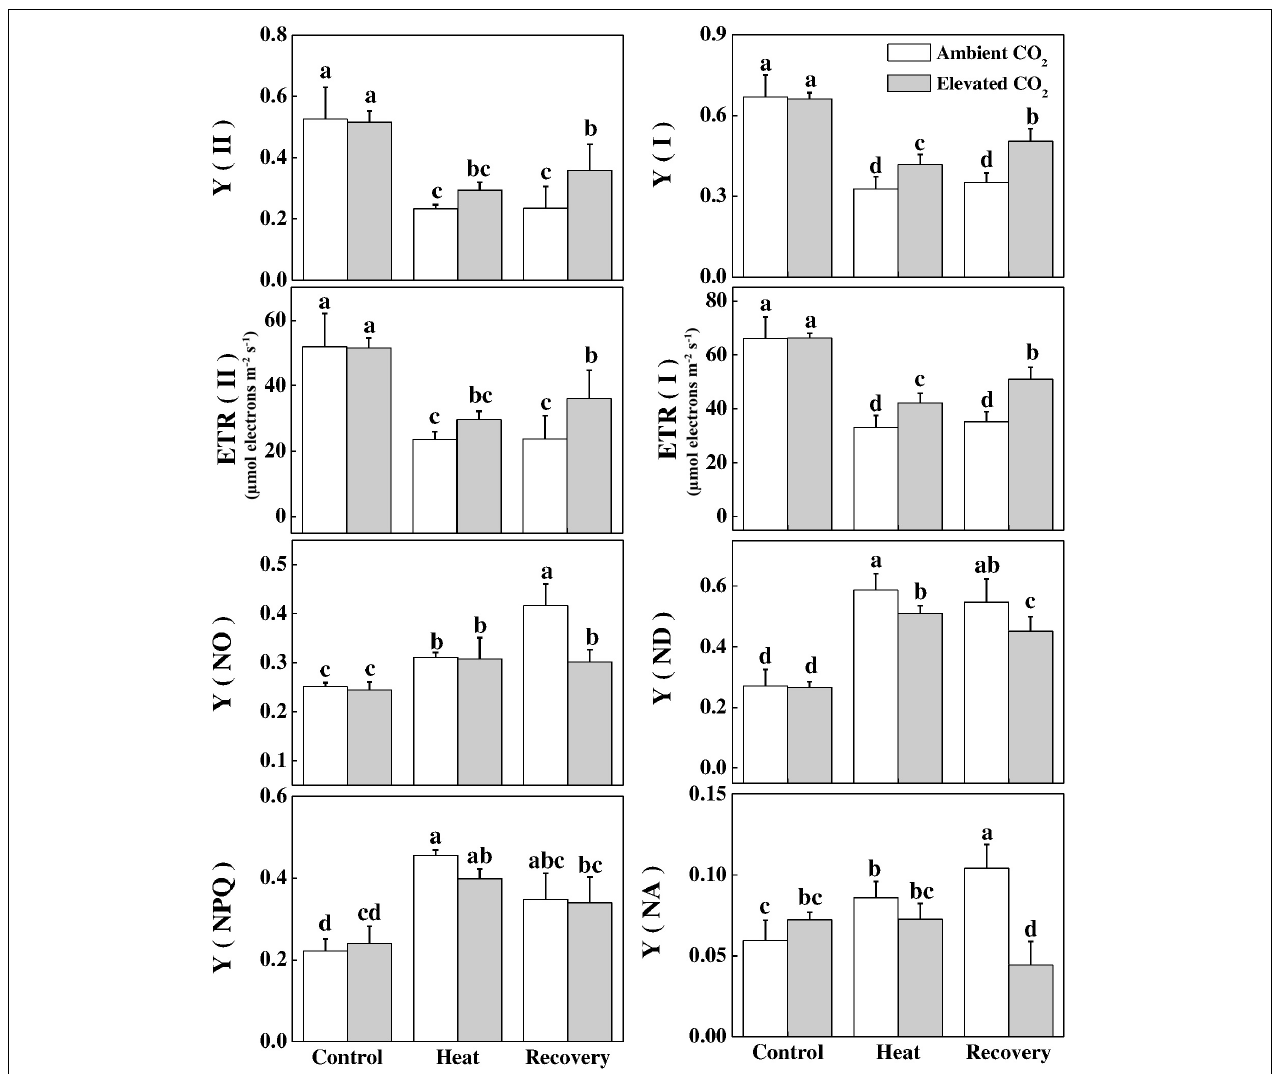
FIGURE 4 | Effects of elevated CO 2 and heat stress either alone or combined on different chlorophyll fluorescence parameters in tomato plants. Tomato seedlings kept at ambient (380 µ mol mol − 1 ) and elevated CO 2 concentration (800 µ mol mol − 1 ) were challenged with a 24 h heat stress (42 ◦ C temperature) and then allowed to recover for 24 h. The bars (means ± SD, n = 6) labeled with different letters are significantly different at P < 0.05 according to Tukey’s test. The effective quantum yield of PSII, Y(II); electron transport rate in PSII, ETR(II), non-photochemical quenching, Y(NPQ); non-regulated non-photochemical energy loss in PSII (non-regulated energy dissipation at PSII centers), Y(NO); effective quantum yield of PSI, Y(I), electron transport rate in PSI, ETR(I); non-photochemical energy dissipation in PSI due to acceptor side limitation (acceptor-limited quenching), Y(NA); and non-photochemical energy dissipation in PSI due to donor side limitation (donor-limited quenching),